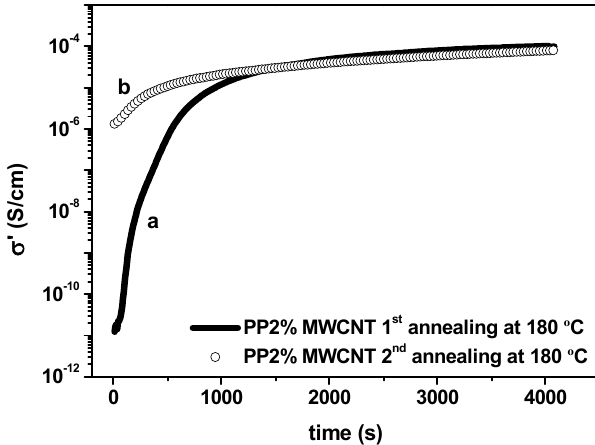
Figure 7. Electrical DC conductivity as a function of time during a quiescent annealing at 180 °C for 2 wt.% MWCNT/PP nanocomposite: ( a ) 1 st annealing; ( b ) 2 nd annealing.